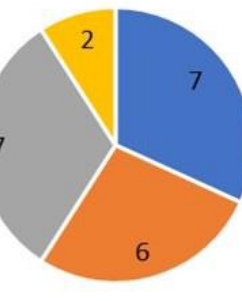
“business”, and one person having a double function “government” and “business”. Left chart including students, right